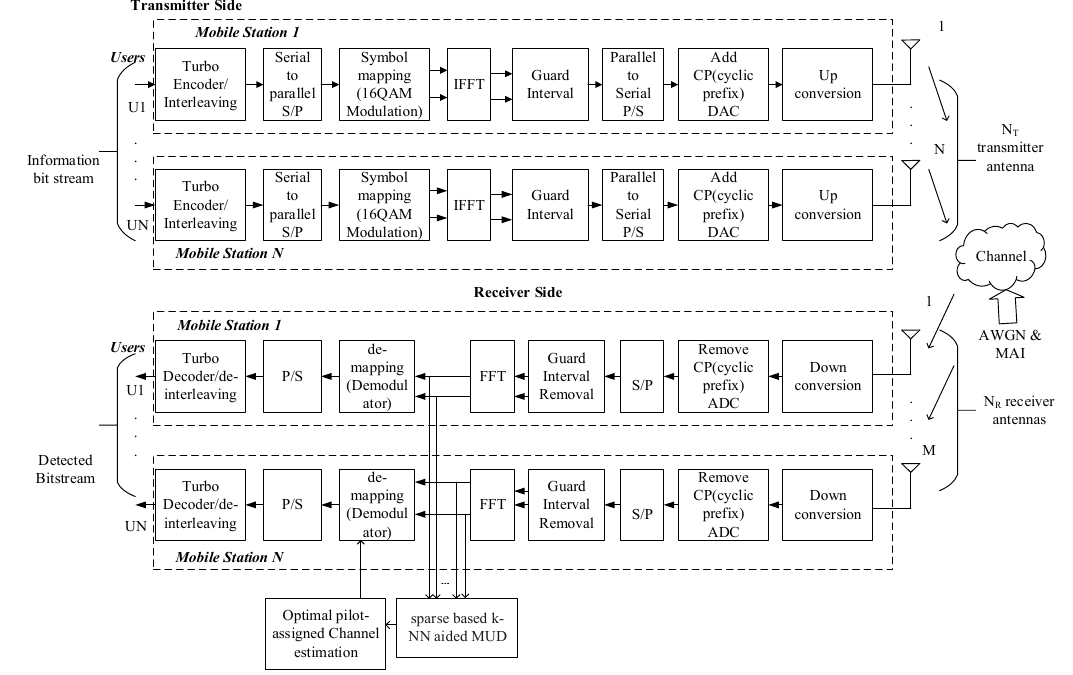
Figure 1. Proposed multi-user detection (MUD) and channel estimation (CE).